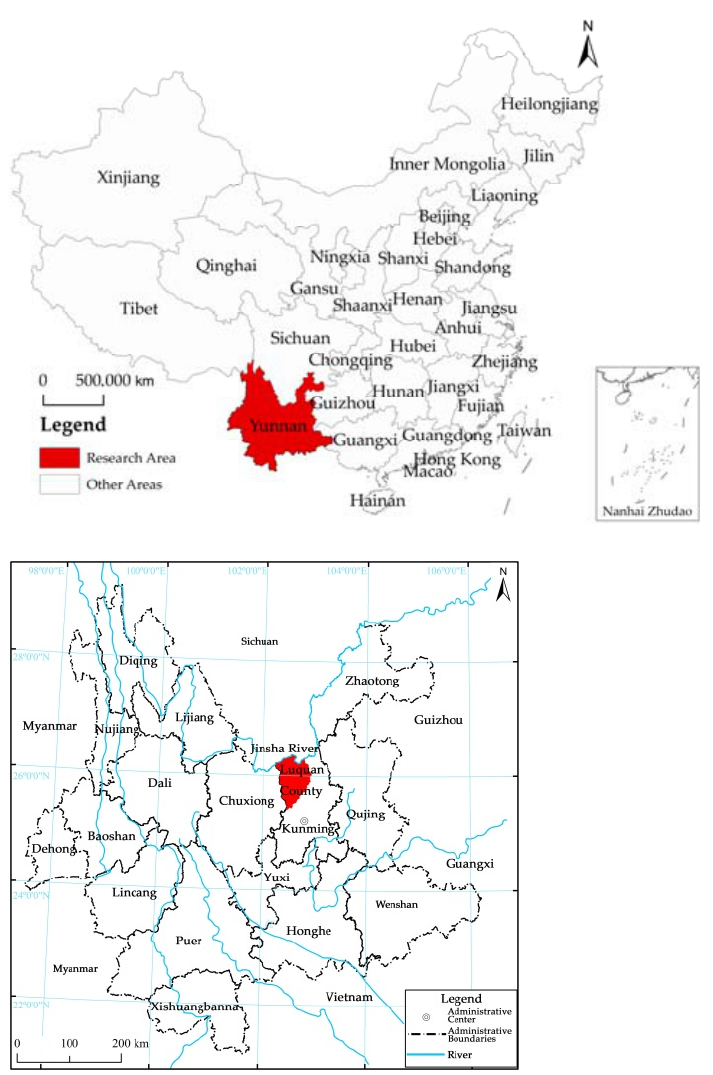
Figure 1. Geographical location of Luquan County.